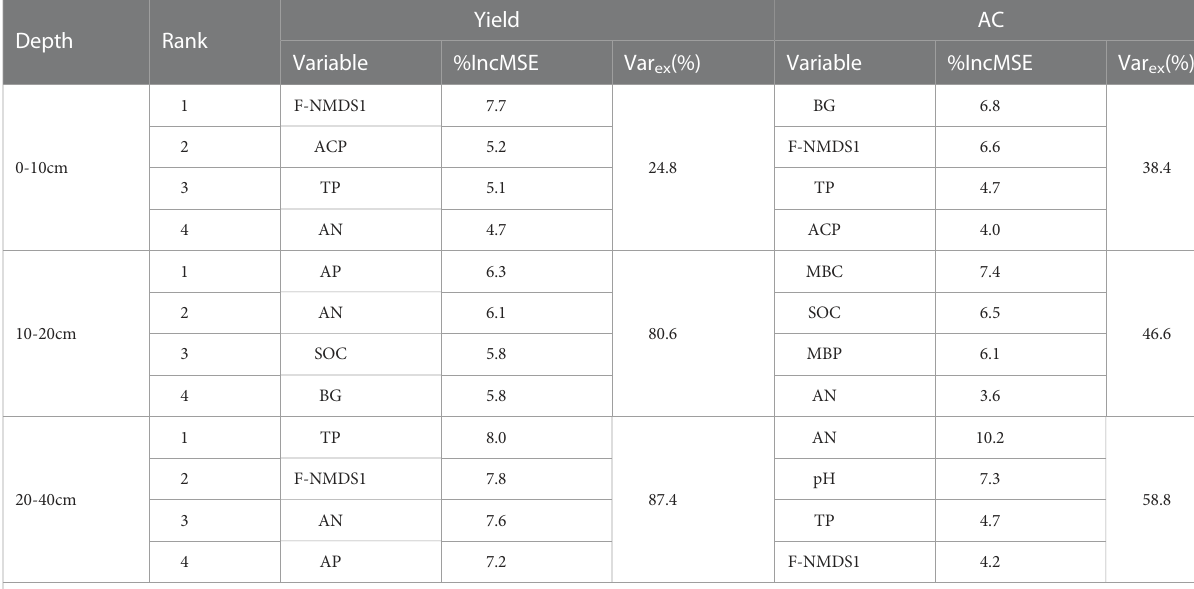
TABLE 4 Top four importance (percentage of increase in mean square error, %IncMSE) of variables and the percentage of the explained variance (Varex) to the change in yield and AC using the random forest models.